Question: Compose a caption that would accompany this figure in a paper.
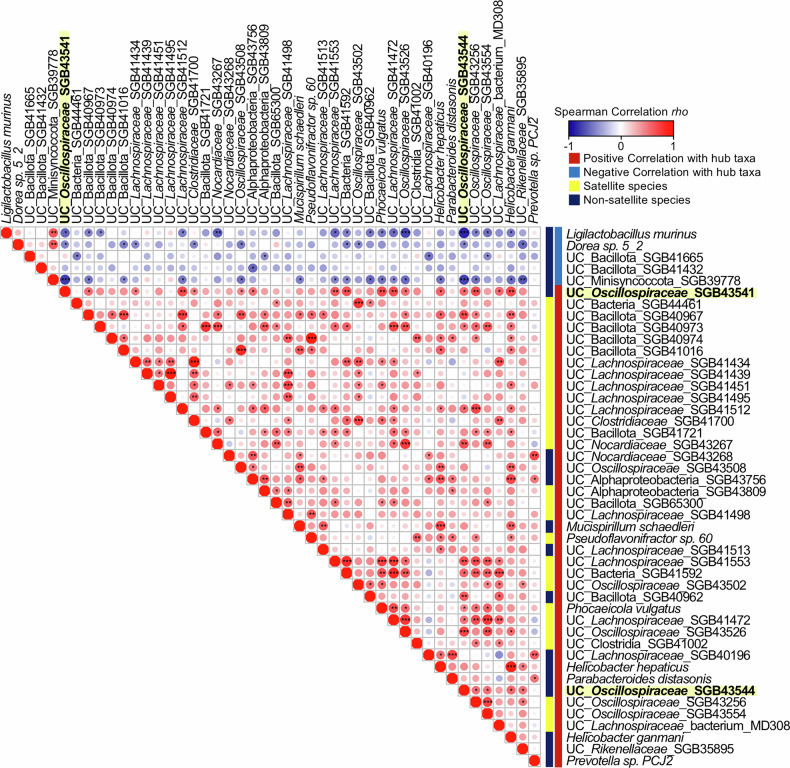
Answer: Association between network hub taxa and co-modulated microbial communities in Veillonella ratti MHL0042-treated experimental autoimmune encephalomyelitis mice cecum. Correlogram illustrating modulated species associated with the network hub taxa using Spearman correlation analysis. The color intensity and square size reflect the strength of the coefficients. * P < 0.05; ** P < 0.005; *** P < 0.0005.